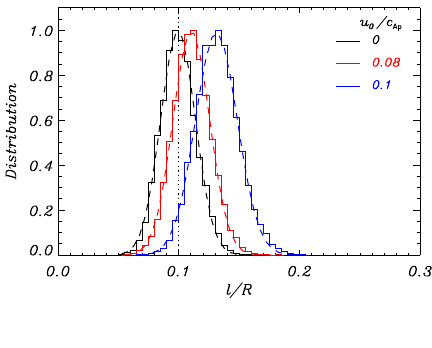
Fig. 92 Seismology of resonantly damped thread oscillations in the presence of flows. The figure shows normalised histograms for the seismologically estimated values of l / R for three values of the flow velocity. The dashed lines are the Gaussian fits and the vertical dotted line is the actual value of l / R . Image reproduced with permission from Soler et al. (2012), copyright by